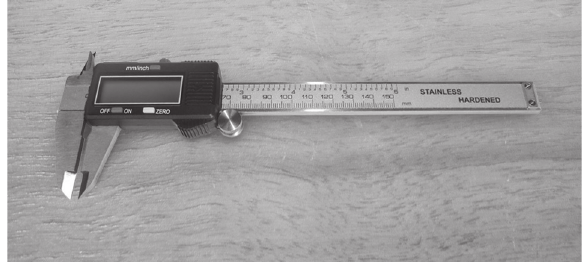
Figura 1 - Paquímetro digital Fonte: Acervo das